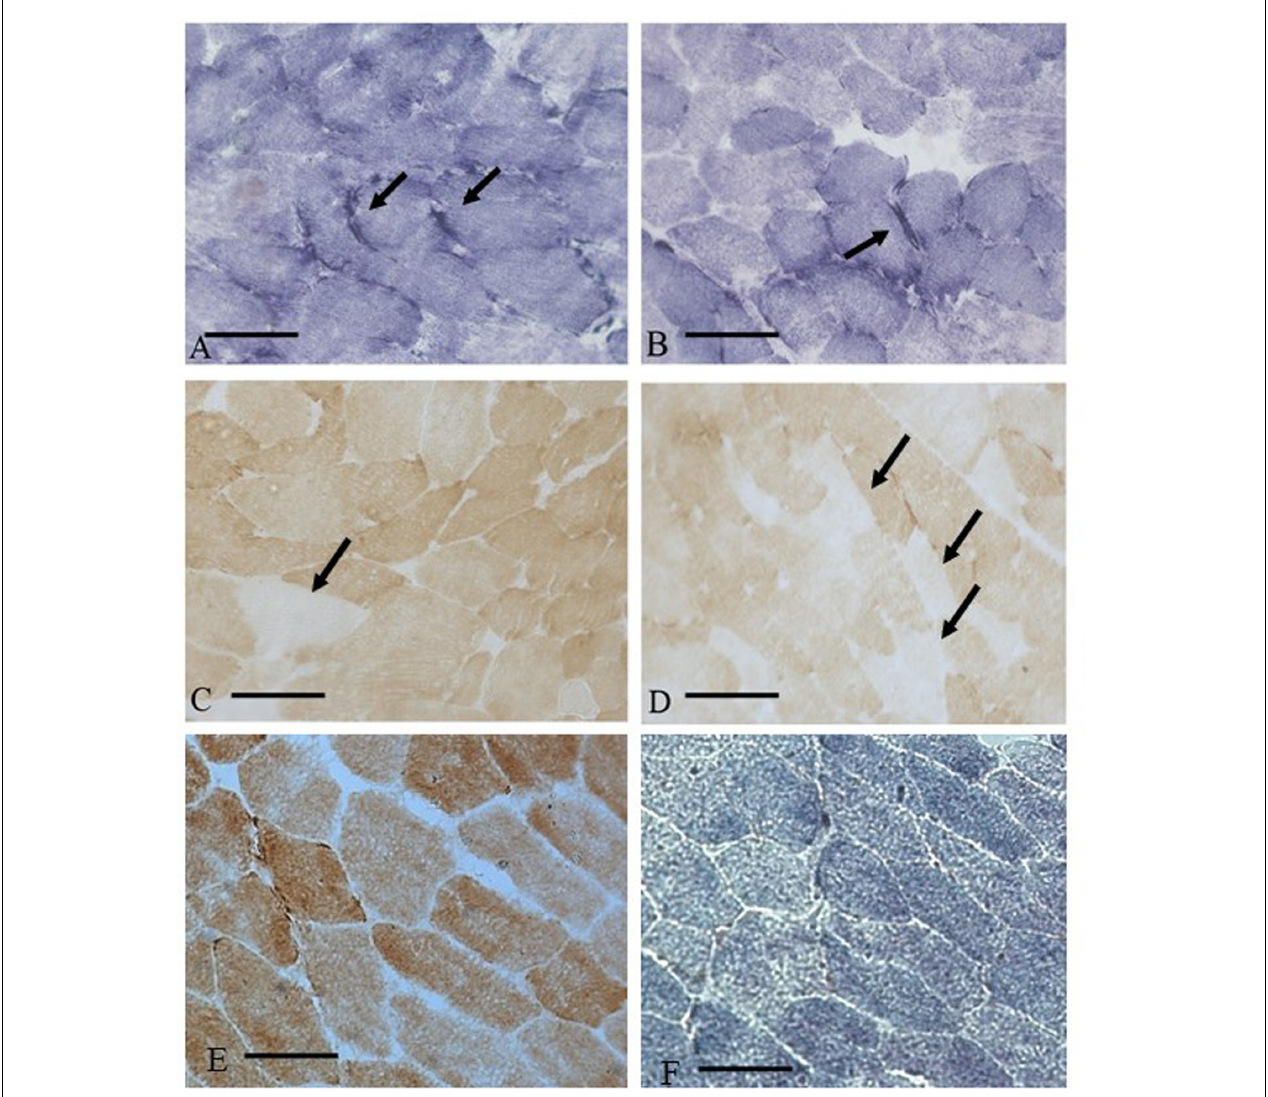
FIGURE 1 | Muscle biopsy of a patient (MM) with statin myopathy showing SDH hyper-reactive and COX negative fibers. (A,B) 20 × SDH staining showing muscle fibers with hyper-reactive sub-sarcolemmal rims (arrows). (C,D) COX staining with several COX negative fibers (arrows). (E,F) COX and SDH staining from a control